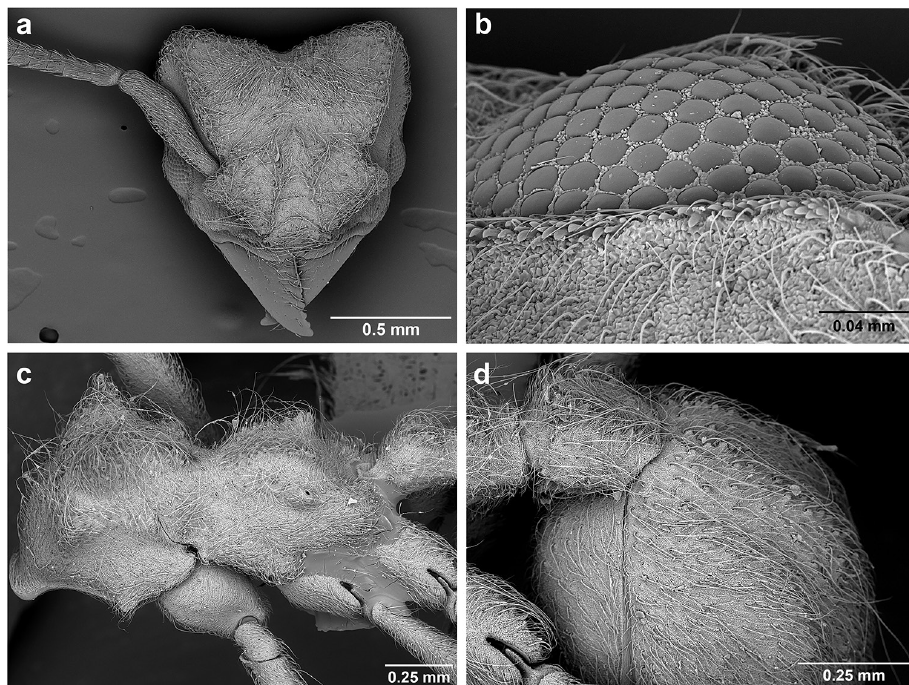
Figure 62. S. scrobifer worker (USNMENT01125273), SEM images. a Head, full-face view b eye c mesosoma, lateral view d metasoma (partial), dorsolateral